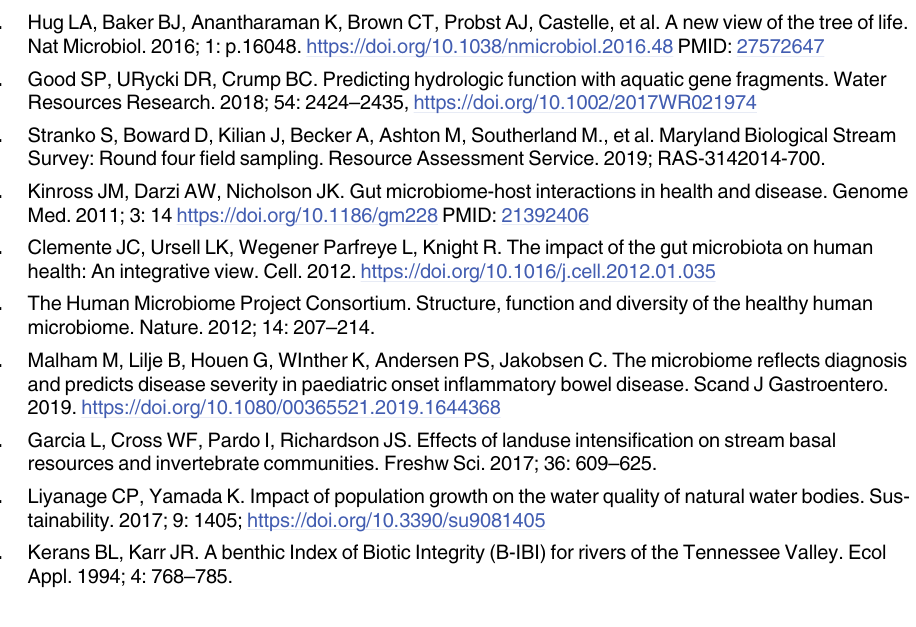
S3 Fig. Responses of diagnostic orders to important water chemistry gradients. (TIFF) S4 Fig. Responses of diagnostic orders to the BIBI and land use gradients. (TIFF) S5 Fig. Responses of diagnostic orders to water chemistry gradients.